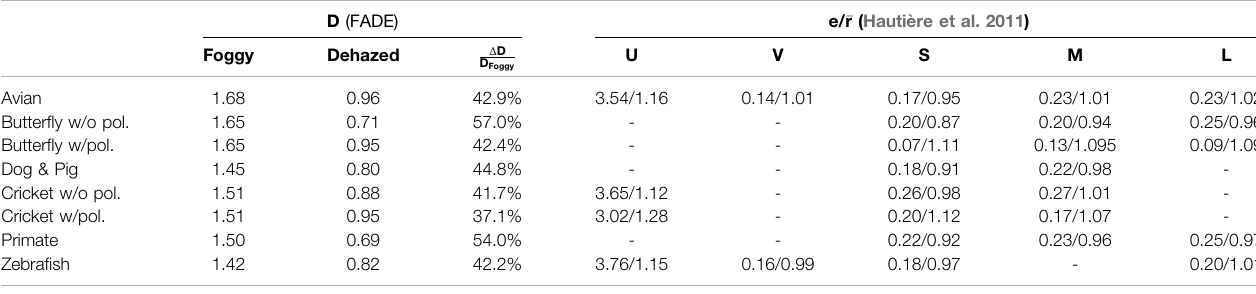
TABLE2| Evaluationresultsofdehazingforscene1.Theevaluationmetric D (FADE(ChoiandYou,2015))isappliedonsRGBimages,whereasthemetrics e and (cid:1) r (Hautière et al., 2011) are applied per spectral channel.